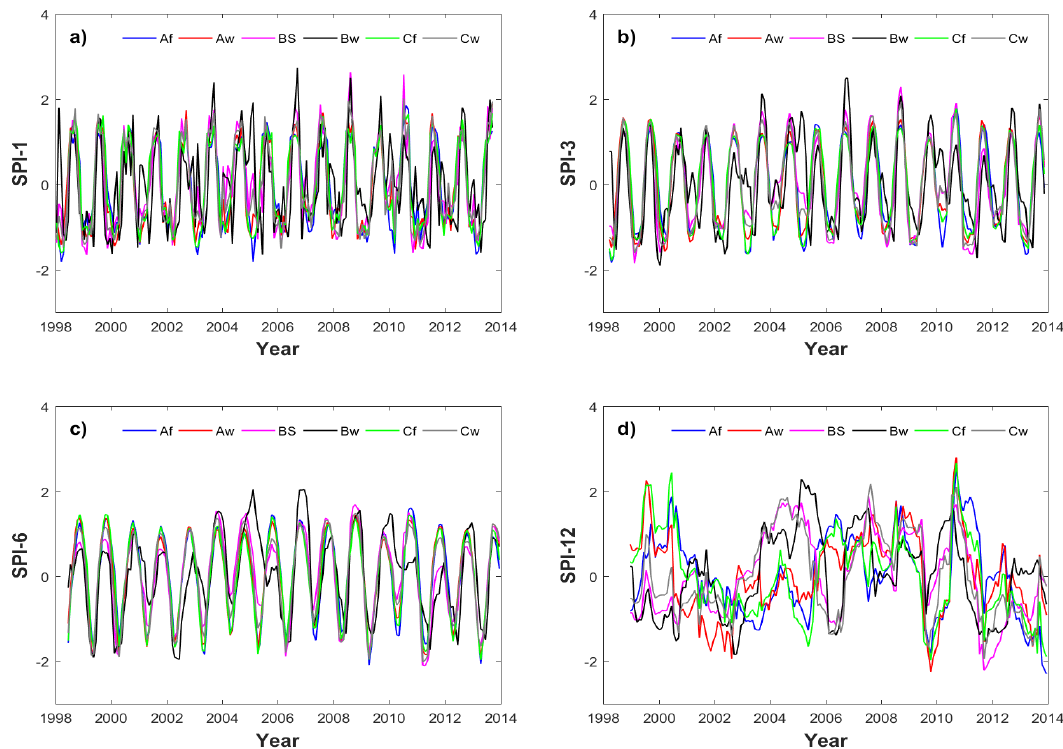
Figure 5. Standardized Precipitation Index (SPI) averaged over Mexico from 1998 until 2014 at different climate regions (color lines) and timescales: one month ( a ); three months ( b ); six months ( c ); and twelve months ( d ).